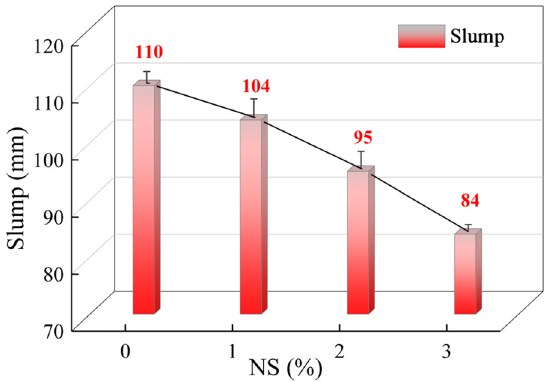
Figure 5: E ff ect of NS concentration on the slump of